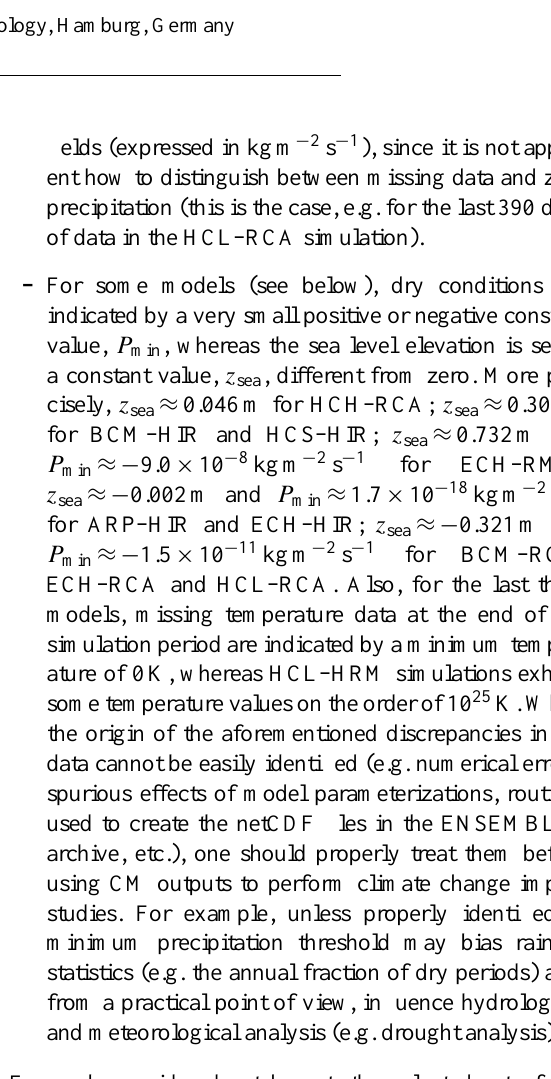
Fig. 1. Locations of representative Mediterranean catchments considered in this study (see also Table 1): 1 – Thau (France), 2 – Riu Mannu (Italy), 3 – Noce (Italy), 4 – Kocaeli (Turkey), 5 – Gaza (Palestine), 6 – Chiba (Tunisia). Model verification areas that correspond to the 4 (cid:2) 4 stencil of ENSEMBLES grid-points centered in each catchment appear as shaded; see main text for details.